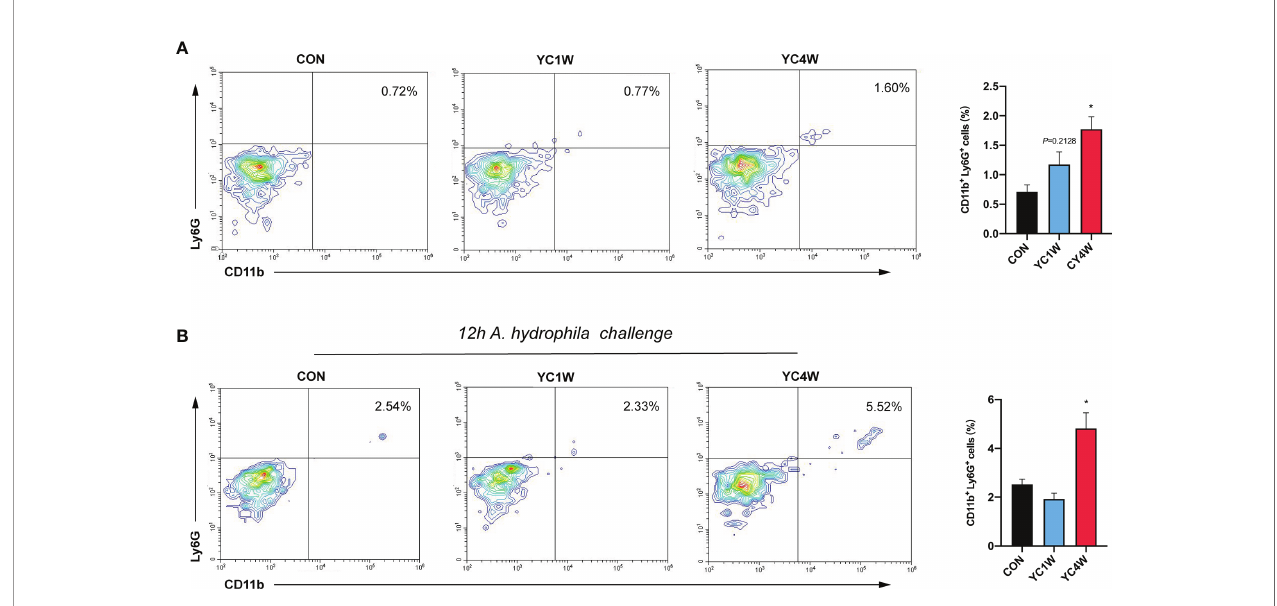
FIGURE 6 | Four-week P. pentosaceus YC administration increases the intestinal neutrophils of zebra fi sh and enhances the recruitment of neutrophils under pathogen infection. (A) Flow cytometry analysis of intestinal neutrophils of zebra fi sh from CON, YC1W, and YC4W groups ( n = 3). (B) Flow cytometry analysis of intestinal neutrophils of zebra fi sh from CON, YC1W, and YC4W group. All zebra fi sh were challenged with 10 8 CFU/ml A. hydrophila for 12 h before intestine collection ( n = 3). Numbers indicate the percentage CD11b + Ly6G + neutrophils in intestinal cells. Data are represented as mean ± SEM. * p < 0.05 by one-way analysis of variance followed by Dunnett ’ s multiple comparisons